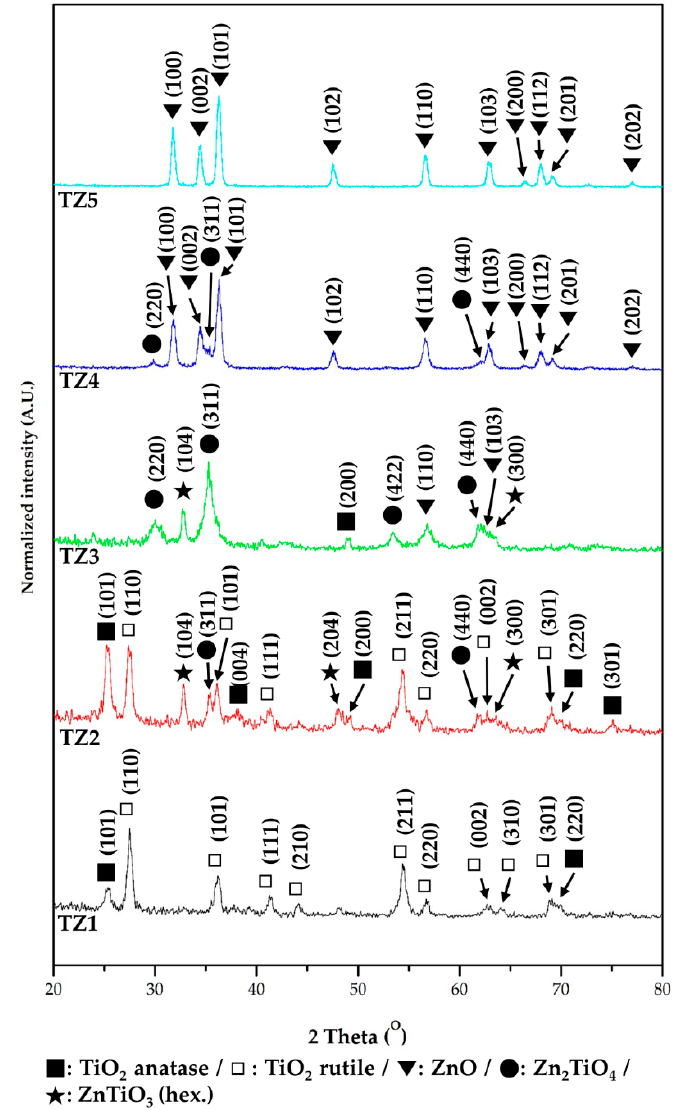
Figure 7. X-ray di ff ractometer (XRD) spectra of annealed Ti–Zn complex oxide nanofibers with di ff erent Figure 7. X-ray diffractometer (XRD) spectra of annealed Ti–Zn complex oxide nanofibers with molar ratios of Ti and Zn (TZ1: 10:0, TZ2: 9:1, TZ3: 5:5, TZ4: 1:9 and TZ5: different molar ratios of Ti and Zn (TZ1: 10:0, TZ2: 9:1, TZ3: 5:5, TZ4: 1:9 and TZ5: 0:10).